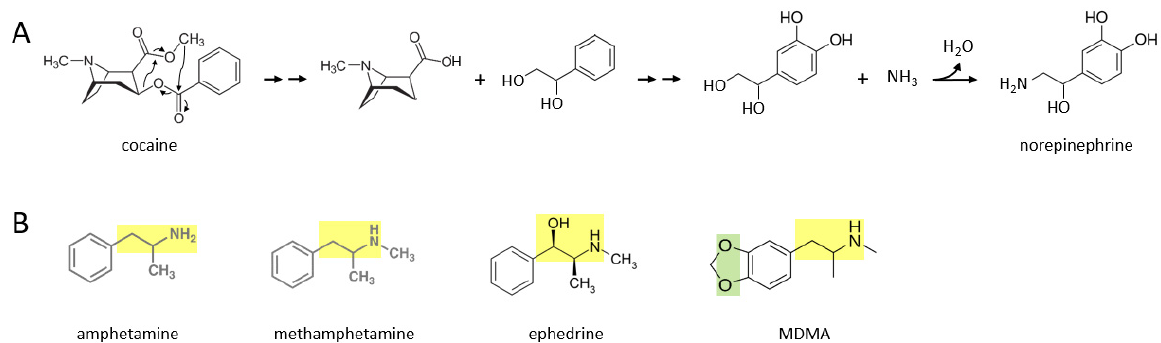
Figure 1. Various stimulants may be acutely converted to catecholamines in vivo. ( A ) Cocaine may be transformed to norepinephrine through a series of proposed chemical reactions. Double arrows indicate two or more reactions. ( B ) Various other stimulants possess moieties (yellow: a two hydrocarbon chain attached to a nitrogen atom; green: two oxygen atoms attached to the benzene ring) that may allow them to be enzymatically converted to dopamine, norepinephrine, or epi- nephrine.